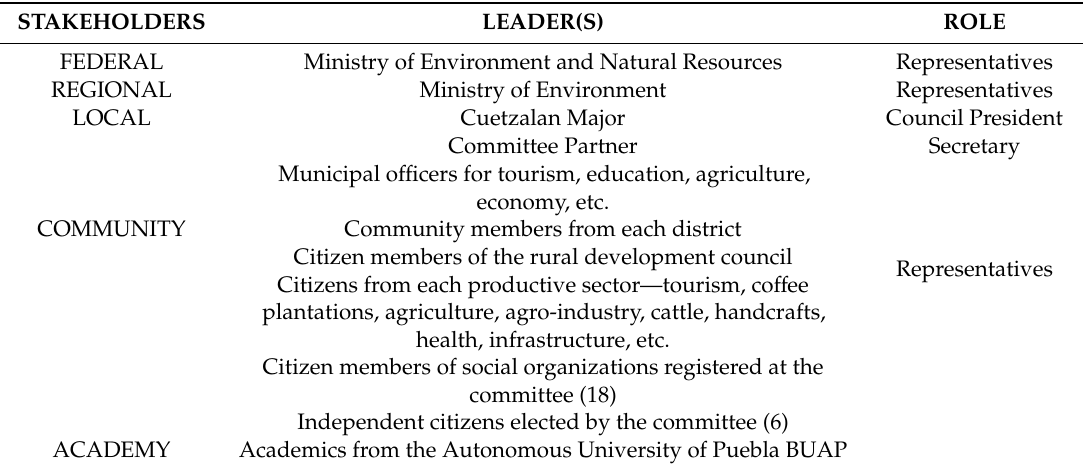
Table 3. COTIC (Comit é de Ordenamiento Ecol ó gico Territorial Integral de Cuetzalan) / COEC (Comit